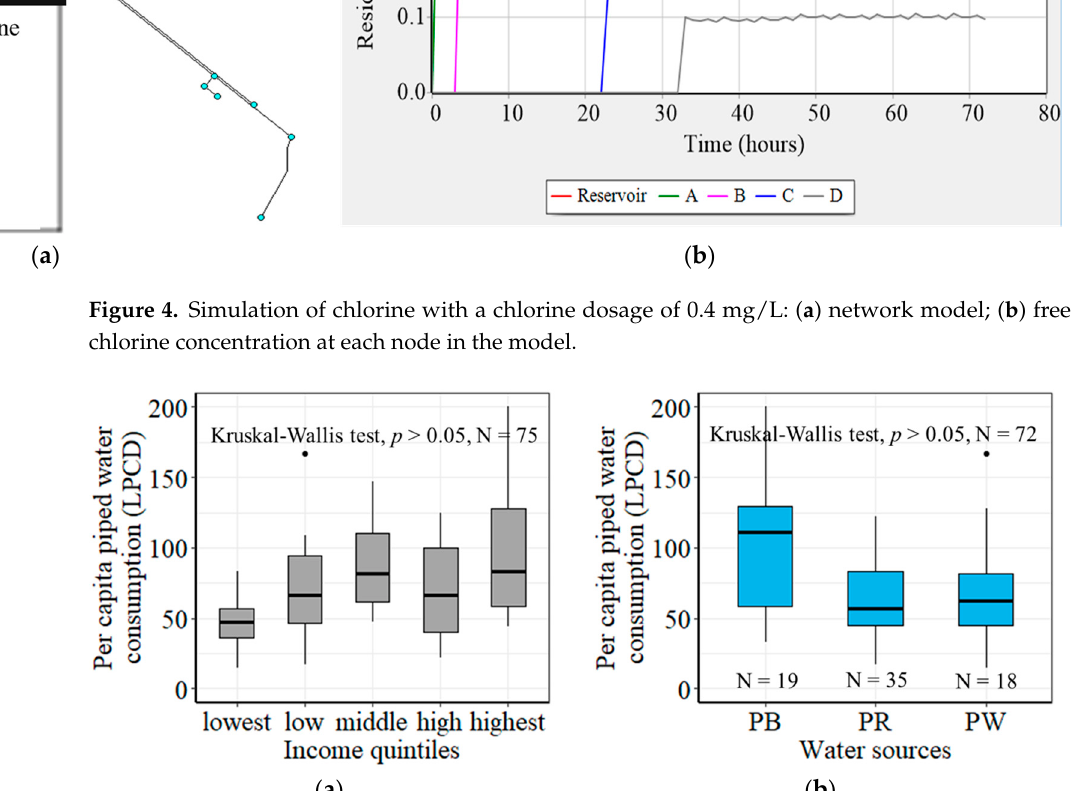
Figure 4. Simulation of chlorine with a chlorine dosage of 0.4 mg/L: ( a ) network model; ( b ) free chlorine concentration at each node in the model.